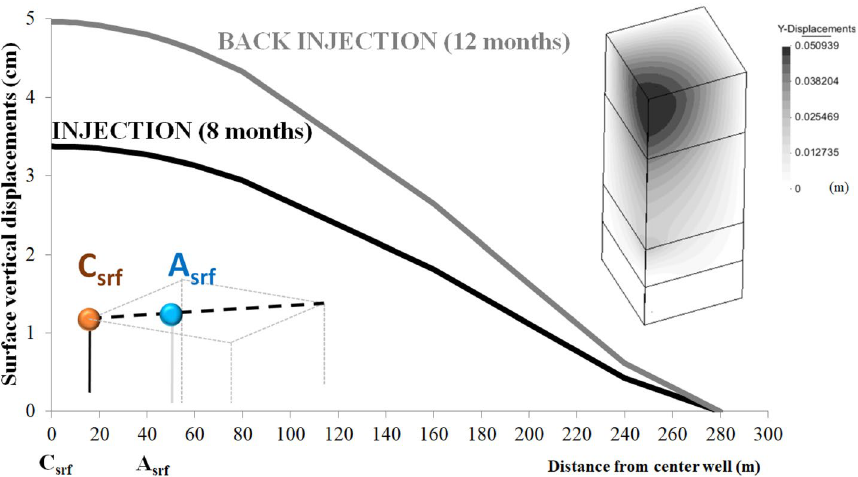
Fig. 15 Surface vertical displacements at the end of the injection and at the end of the back injection . C srf represents the top of the central well and A srf the top of one auxiliary